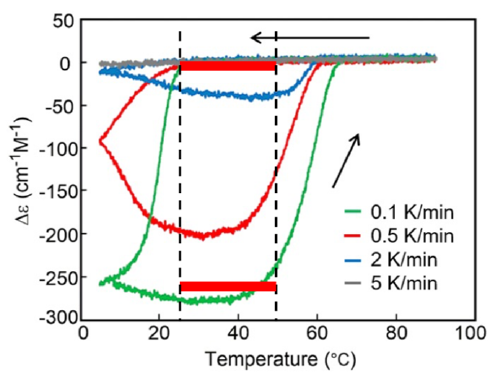
Figure 14. Thermal hysteresis of ( P )– 3 and ( M )– 4 in toluene (2.0 mM) between 90 and 5 °C. Red bold lines indicate bistability involving metastable states. Reproduced from ref. [62] with permission from Chemical Society of Japan. Figure 8. ( a ) Ordinary competitive chemical reactions 2 A → B and 2 A → C , and ( b ) reversible com- petitive chemical reactions B 2 A C involving self-catalytic chemical reactions 2 A + B → 2 B and 2 A + C → 2 C (red square), which are compared with chemical reaction 2 A → B .